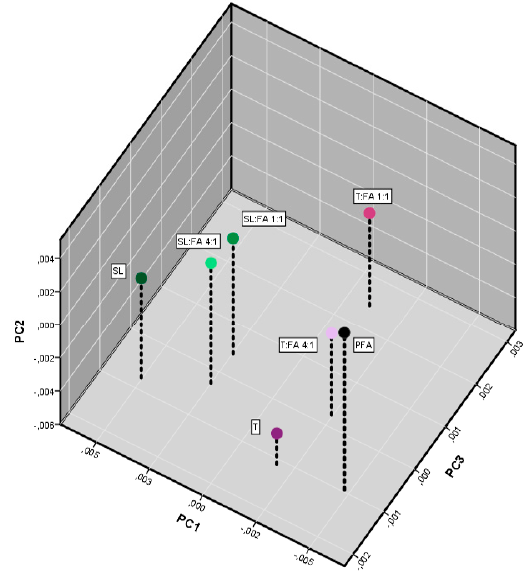
Figure 6. Principal component analysis of the FT-IR spectra of the furanic-phenolic polymers.